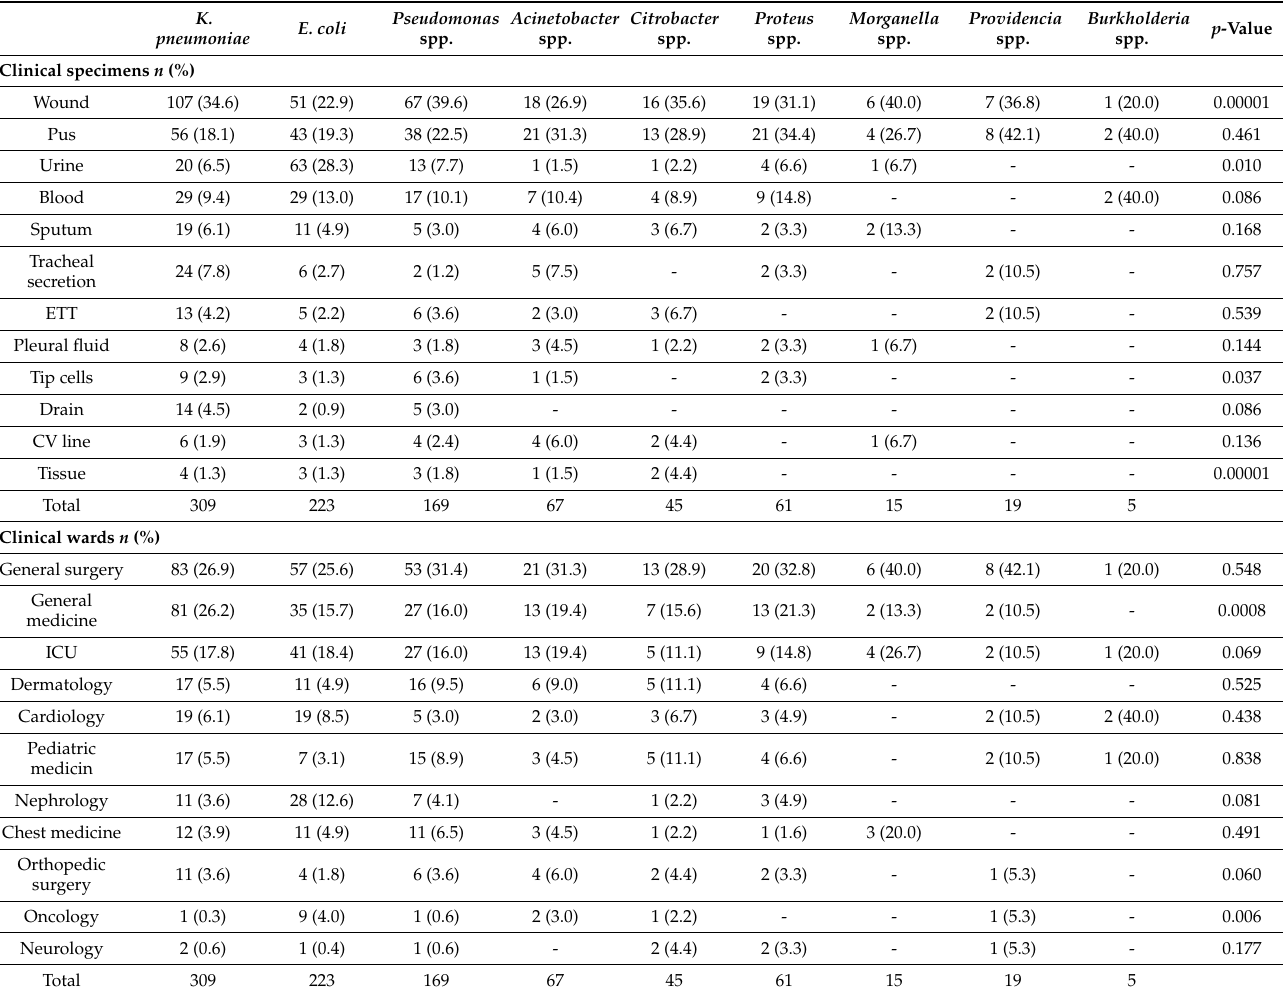
Table 3. Distribution of carbapenem resistance burden among clinical specimens and